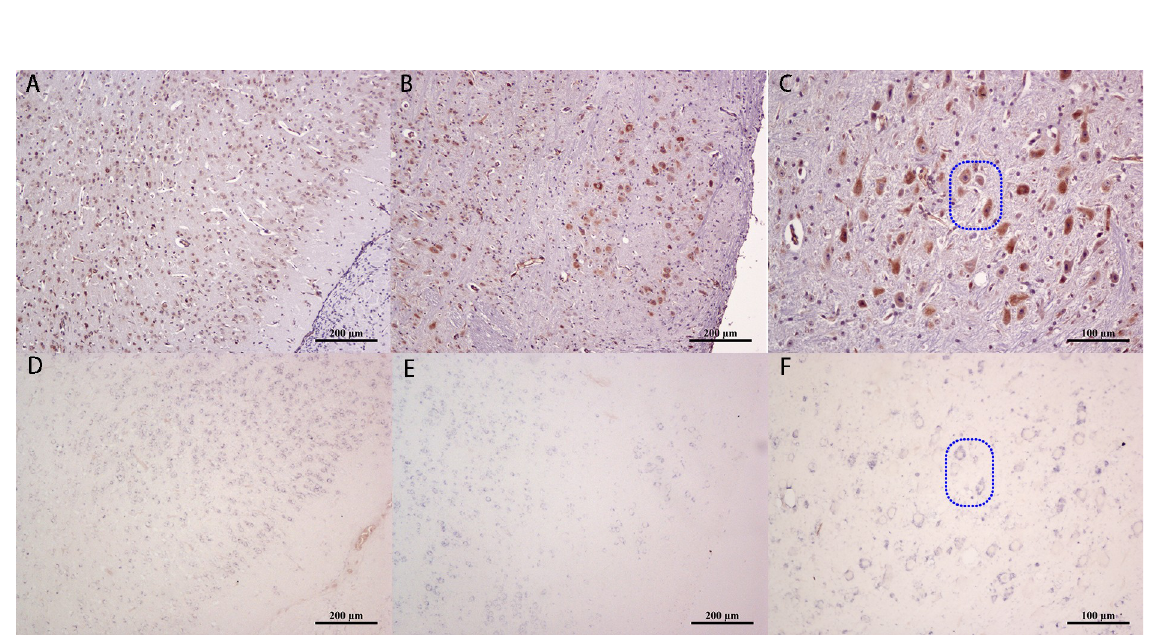
Fig 2. Localization of JEV in the mouse brain 5 dpi. (A-C) Immunohistochemical staining of the JEV E protein antigen in the cerebral cortex, medulla oblongata and thalamus, respectively. (D-F) in situ hybridization staining of the JEV E gene in the three corresponding regions, respectively (Dotted